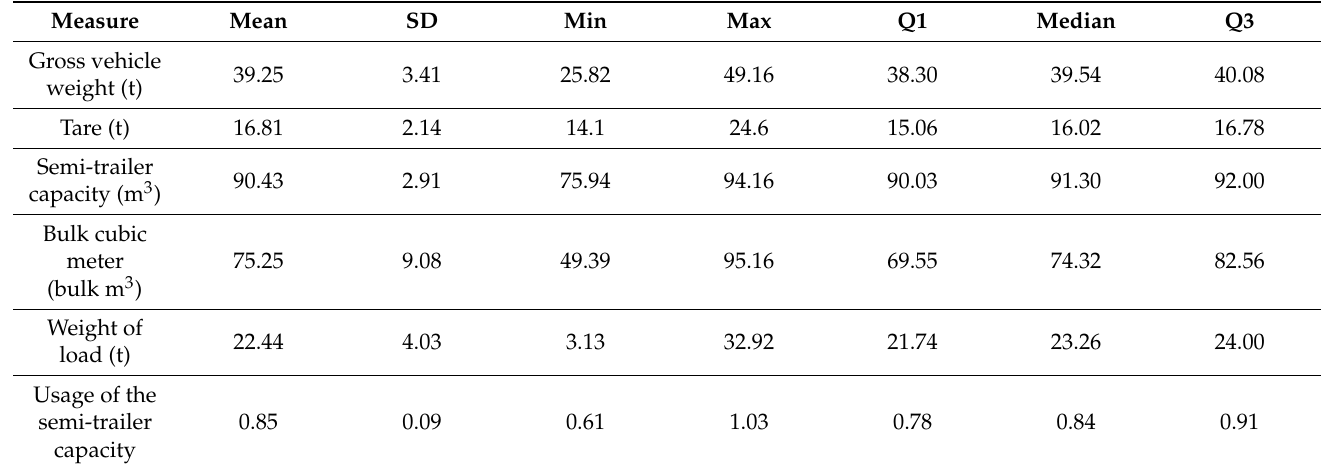
Table 1. Characteristics of the parameters of the transport sets with sawmill